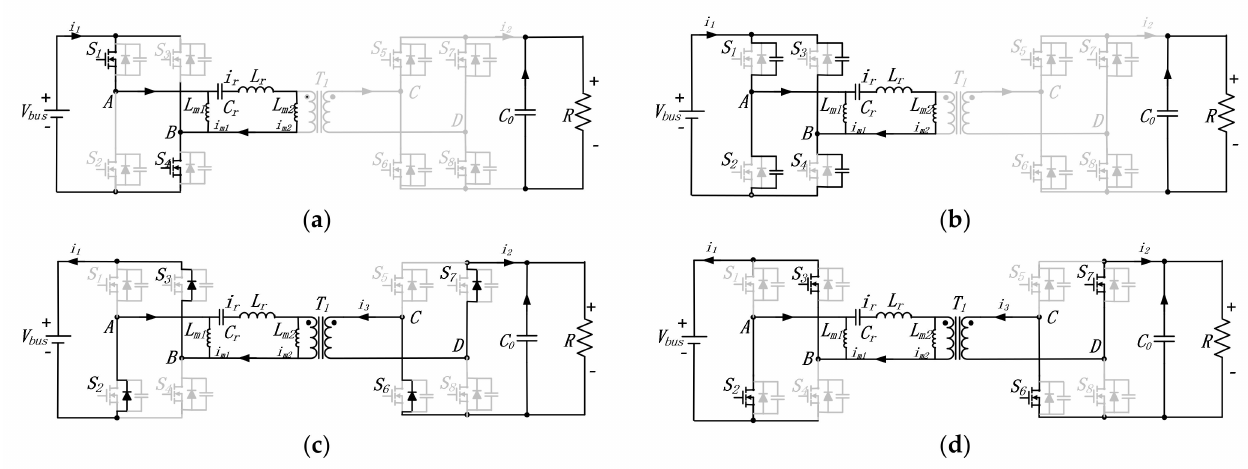
Figure 4. Equivalent circuit for different modes under below-resonance operation, and ( a – d ) show the corresponding circuit operating interval 1 to 4,